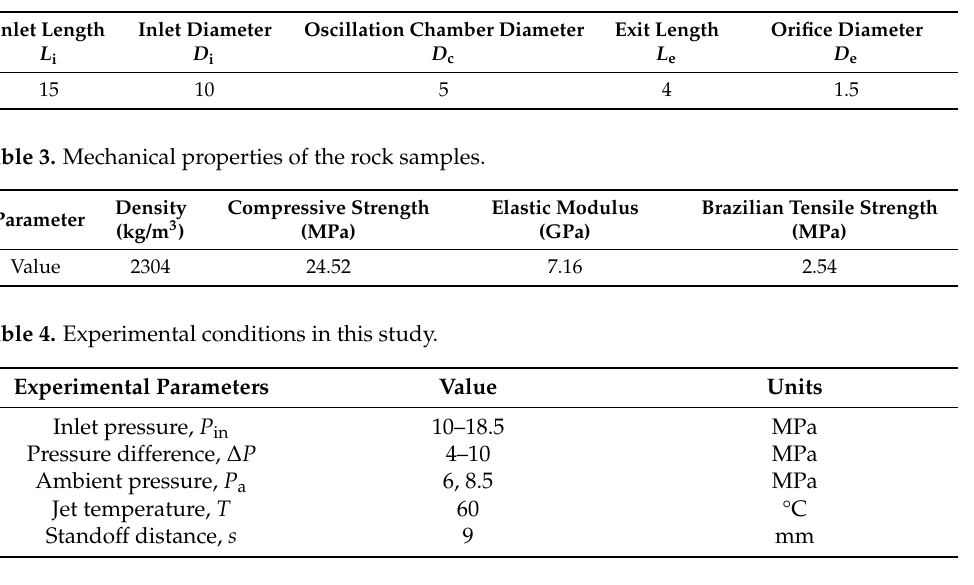
Figure 3. Schematic diagram of the organ pipe nozzle. Table 2. Main structure parameters of organ pipe nozzles (unit, mm).